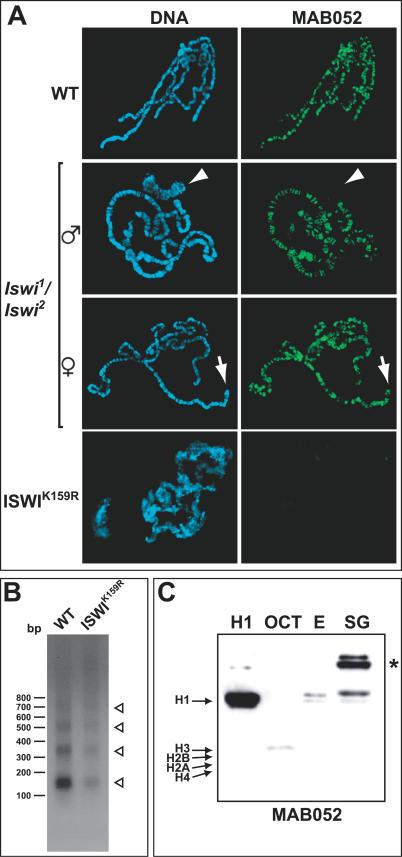
Loss of ISWI Results in Defects in Chromatin Assembly(A) The distribution of histones was analyzed on polytene chromosomes. Wild-type (WT) chromosomes immunostained with a pan-histone antibody (MAB052), which has been described as staining all histones, exhibit uniform histone staining of all arms. Iswi1/Iswi2 male autosomes were uniformly stained, while staining of the X chromosome was dramatically reduced (arrowheads). Iswi1/Iswi2 female chromosomes show uniform staining of all chromosomes, including the X chromosome, which is condensed normally (arrows). Chromosomes from cells that have produced a dominant-negative form of ISWI (ISWIK159R) have dramatically reduced staining.(B) Chromatin isolated from salivary glands of third-instar larvae was partially digested with microccocal nuclease. The open triangles indicate mono-, di-, tri-, and tetra-nucleosomal repeats. The approximate size of the DNA fragments can be visualized by referring to the 100-bp ladder marked alongside the gel. Comparison of digestion patterns of chromatin isolated from wild-type larvae and from larvae expressing ISWIK159R reveals no obvious changes in nucleosome spacing or sensitivity to digestion.(C) Specificity of the reportedly pan-histone MAB052 antibody was analyzed by protein blotting: 20 ng of histone H1 (H1) purified from calf thymus, 1 μg recombinant Drosophila histone octamers (OCT), and embryo (E) and salivary gland (SG) extracts were resolved on a 12% SDS-polyacrylamide gel. The antibody, which is not really pan-histone, has a strong preference for histone H1 and only weakly recognizes recombinant Drosophila histone H3. In embryo and salivary gland extracts, the antibody exhibits a strong preference for histone H1, and also recognizes an uncharacterized band in salivary gland extracts (asterisk).